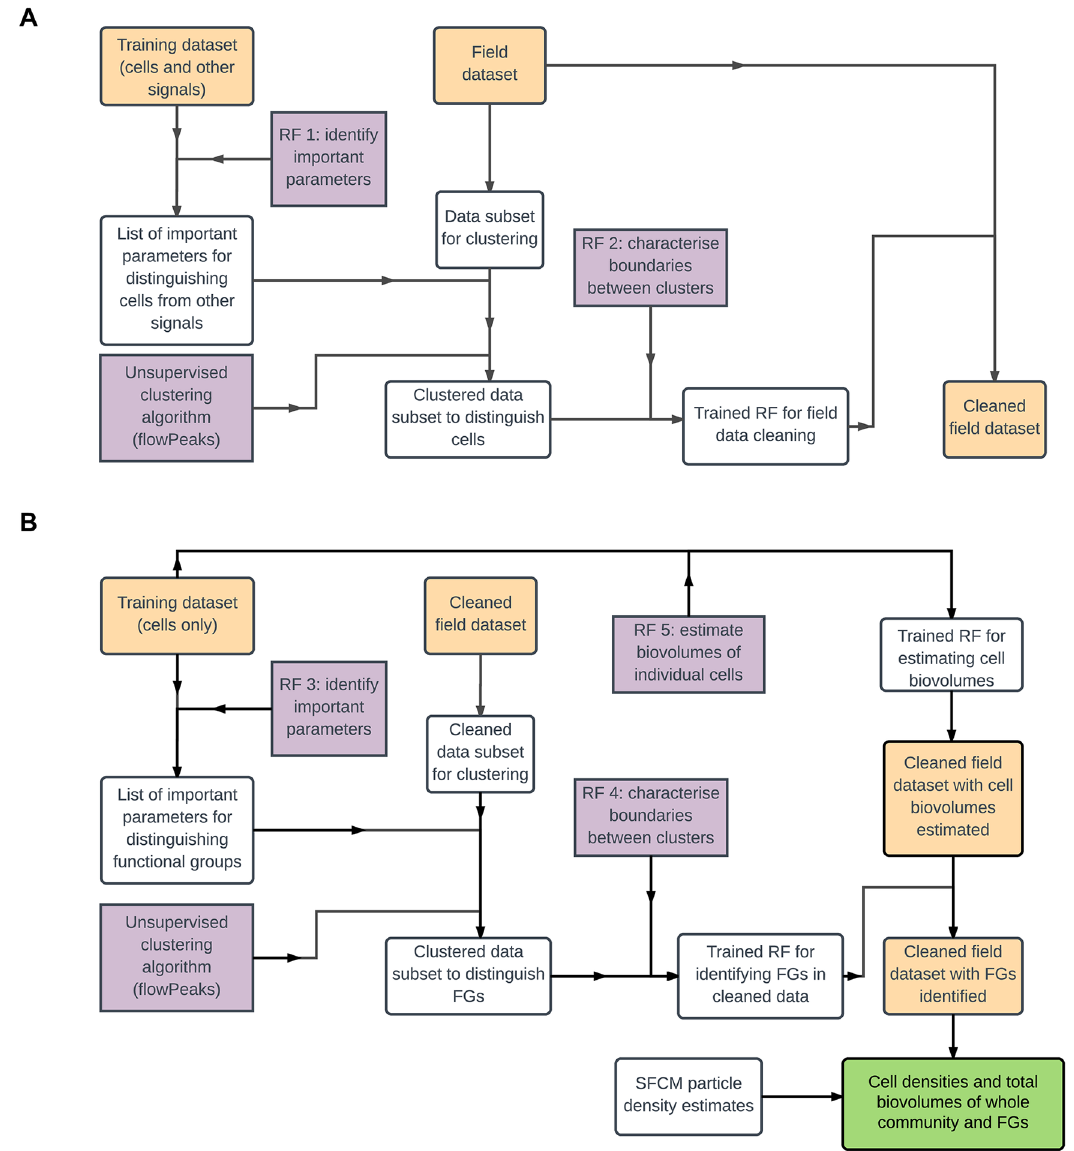
Fig 1. Flow chart illustrating the method we describe in this paper. We have divided this into two parts for clarity: A) Data cleaning, and B) Cell density and biovolume estimation; the output of part A is the primary input for part B. We use two abbreviations: RF for ‘random forest’ and FG for ‘functional group’. Yellow boxes indicate datasets, purple boxes indicate algorithms, the green box indicates the final product obtained, and white boxes contain other operations, objects or data manipulations.